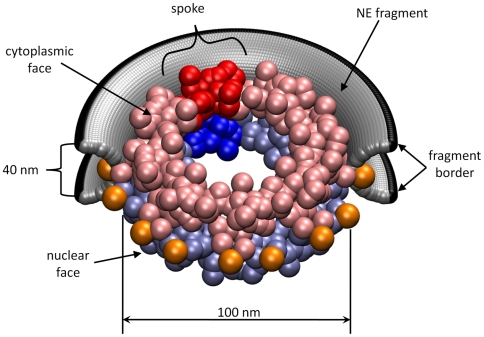
Schematic view of model adopted for the NPC/NE system.The yeast NPC consists of 456 proteins (nucleoporins), shown here as spheres, that form eight identical spokes. The cytoplasmic face of the NPC (facing the viewer) is colored pink, and the nuclear face is colored light blue. A single spoke is highlighted in red/blue. The lumenal ring, consisting of sixteen POM152 nucleoporins is colored orange. Half of the NE fragment is shown in silver, and the border of the NE fragment is colored black.